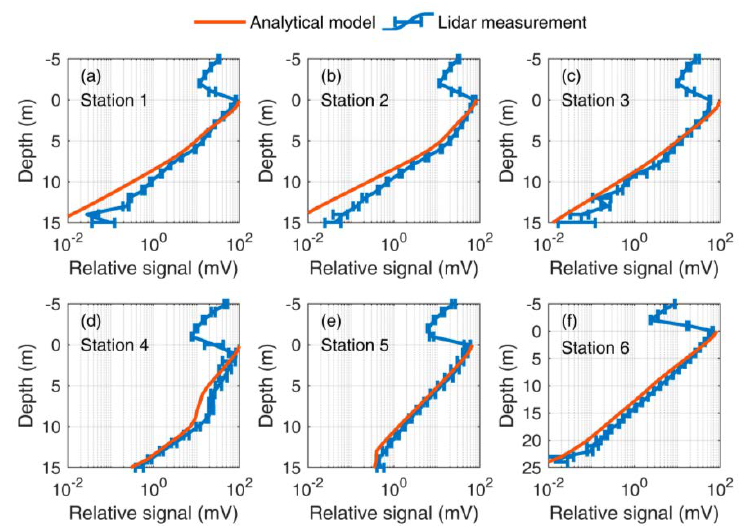
Fig. 3. (a)-(f) are the lidar signals calculated by the analytical model (orange solid lines) and measured by the lidar (blue solid lines with error bars) at Stations 1-6, respectively.